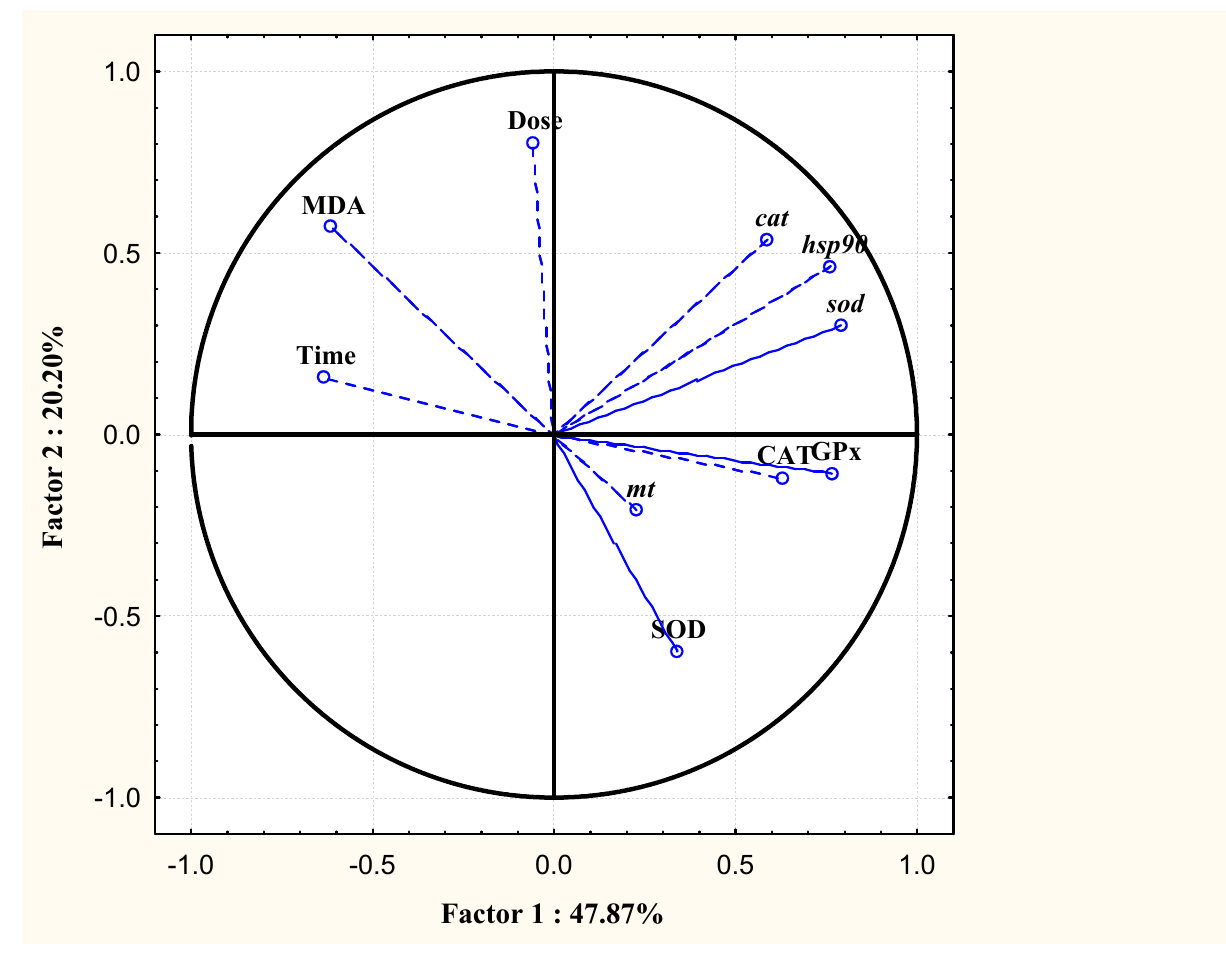
Figure 3. Ordination diagram of the PCA of Na 2 S doses, exposure time, and parameters measured in rice field eel after Na 2 S exposure.